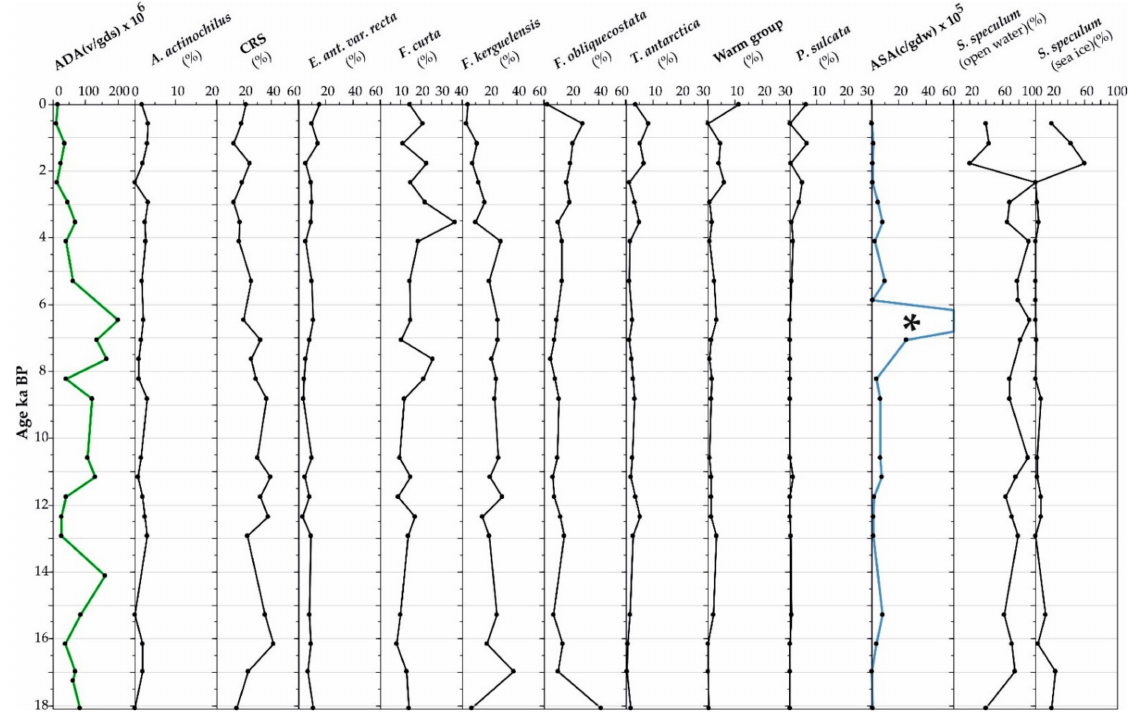
Figure 9. Down-core distribution of diatom and silicoflagellate present in BC03. The variety S. speculum var. monospicata and var. bispicata , with var. speculum , represent the open ocean, while S. speculum var. coronata represents the marginal ice zone and the Ross Sea coastal areas. The asterisk indicates values out of scale (112.23 c/gdw × 10 5